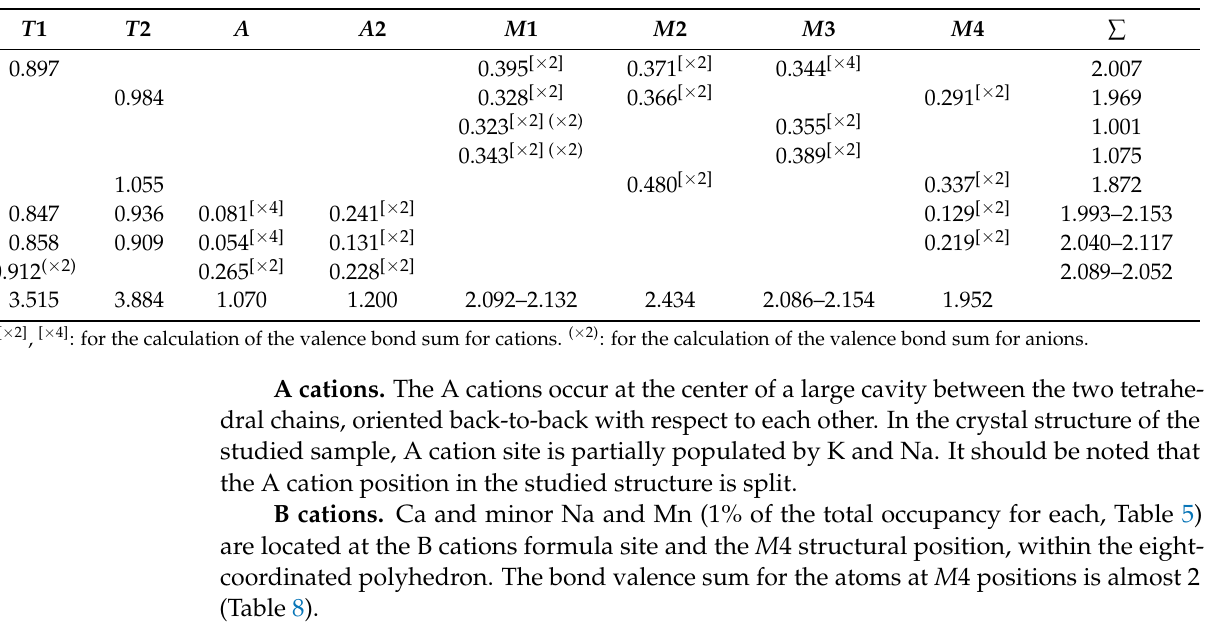
Table 8. Bond-valence sum for the studied potassic-hastingsite using the parameters by